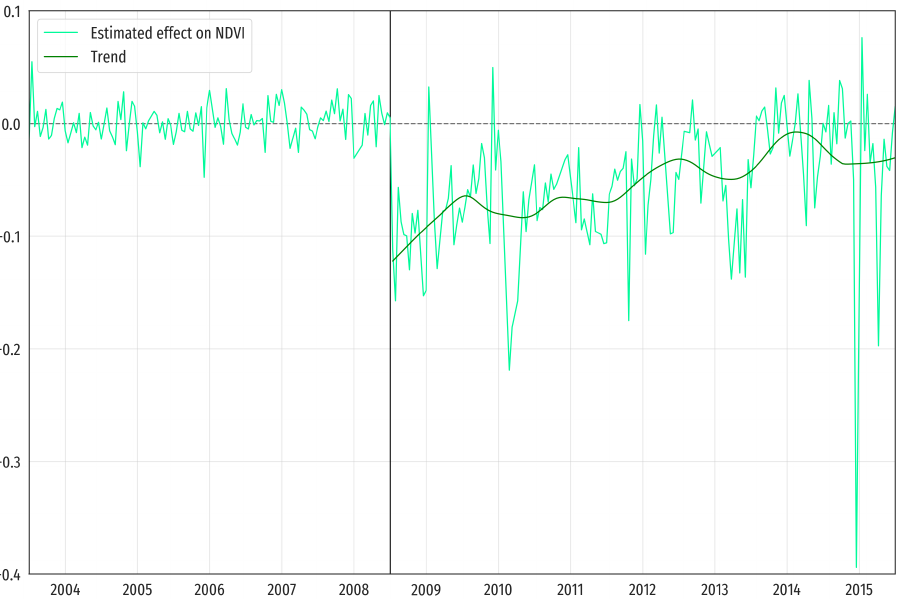
Figure 3. Plot of the effect and trend extracted for the MEU LIGHTNING COMPLEX (MIDDLE) wildfire. The estimated effect is shown in light green. The extracted trend is shown in dark green. This figure shows 5 previous years and 7 years after the wildfire, as this is the inclusion criteria in this